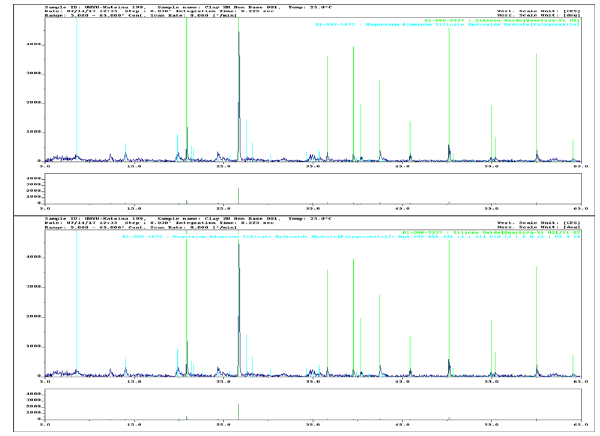
Fig. 4 XRD Spectra of 2-ABC and 2-BBC,